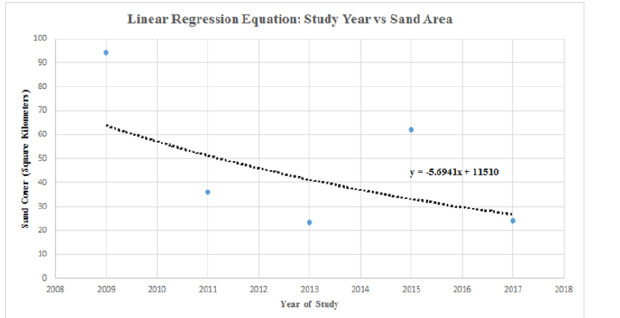
Fig 8: Regression model of sand area change built taking two years